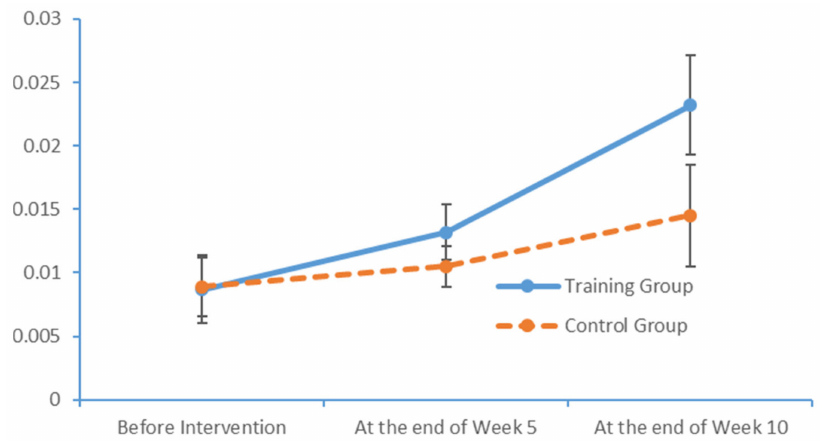
Figure 14. Changes in the power values of the beta_hemi_right wavebands measured in the two subject groups at several time points.